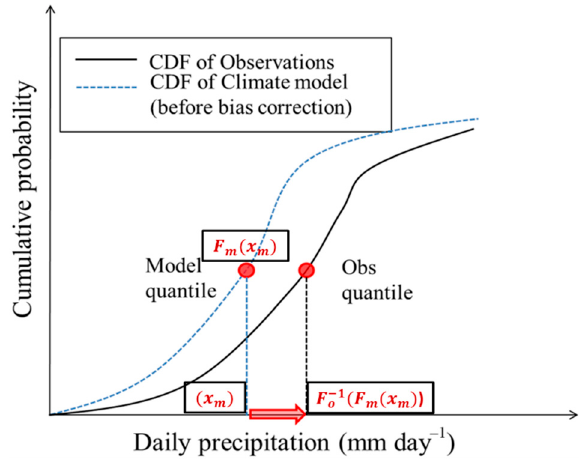
Figure 1. The demonstration of quantile mapping bias correction approach (Modified from Kim et al. [26]). Please refer to Table 1 for the variable definitions.